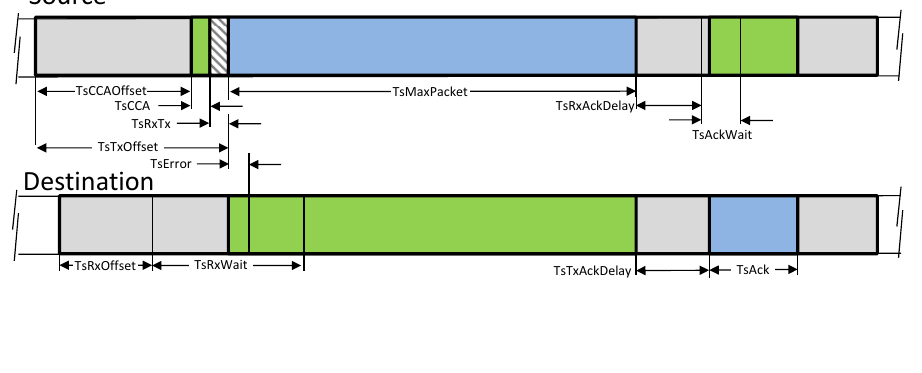
Figure 2. Timing of a dedicated Time Synchronized Mesh Protocol (TSMP) timeslot [1].